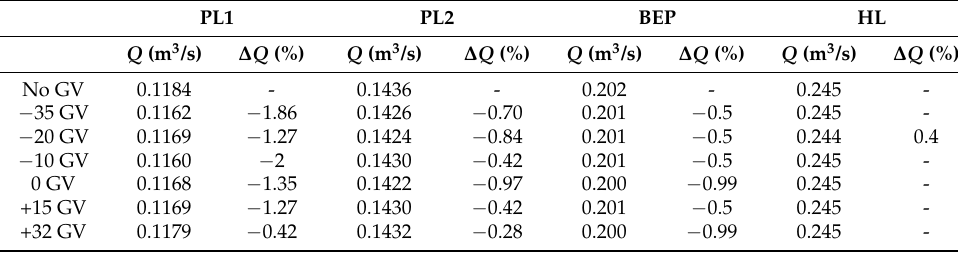
Table A2. Flow rate (Q) and difference ( ∆ Q) without and with the GV